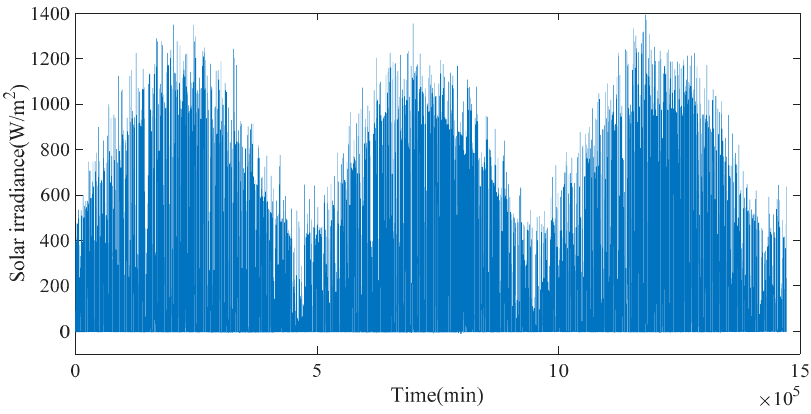
Figure 8. Solar irradiance data of Sioux Falls station from 2014 to 2016.